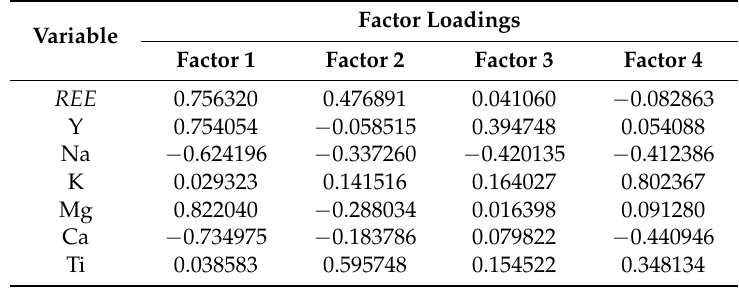
Table 3. Principal Components Analysis (PCA) results of the mineral